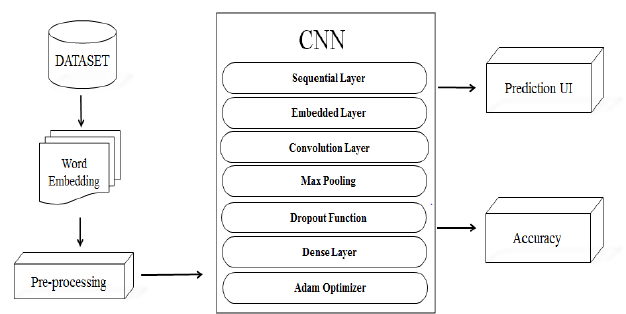
Fig.2. Convolution Neural Network and its Hidden Layers